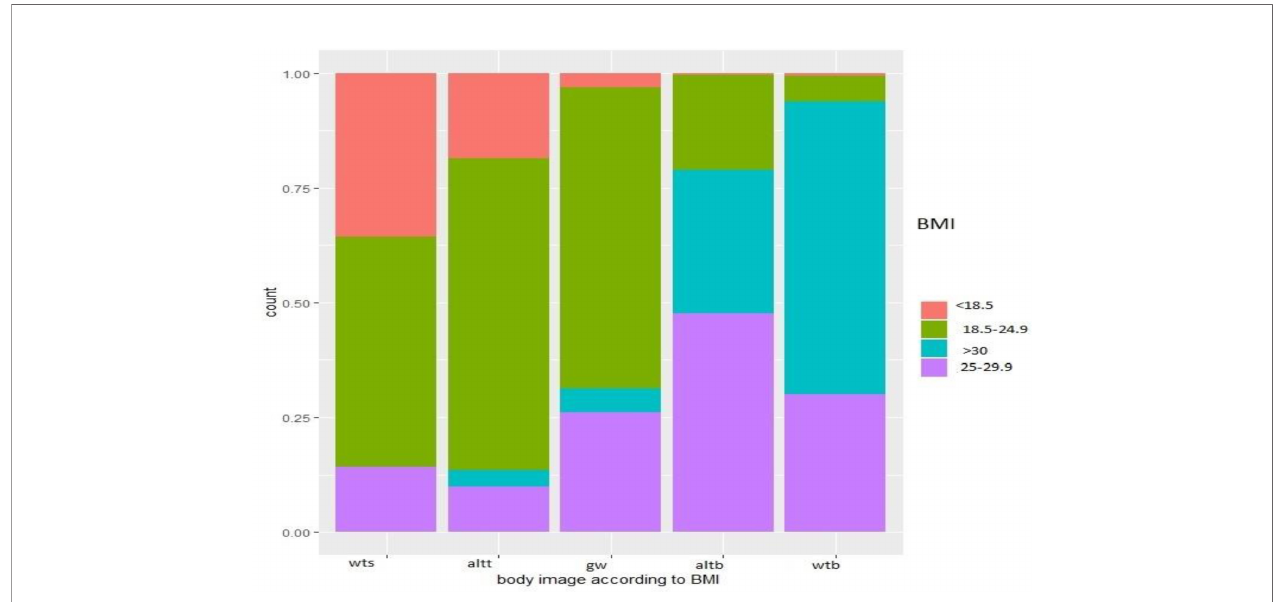
FIGURE 2 | Body image according to BMI. Wts, way too skinny; altt, a little too thin; Gw, quite the good weight; Altb, a little too big; Wtb, way too